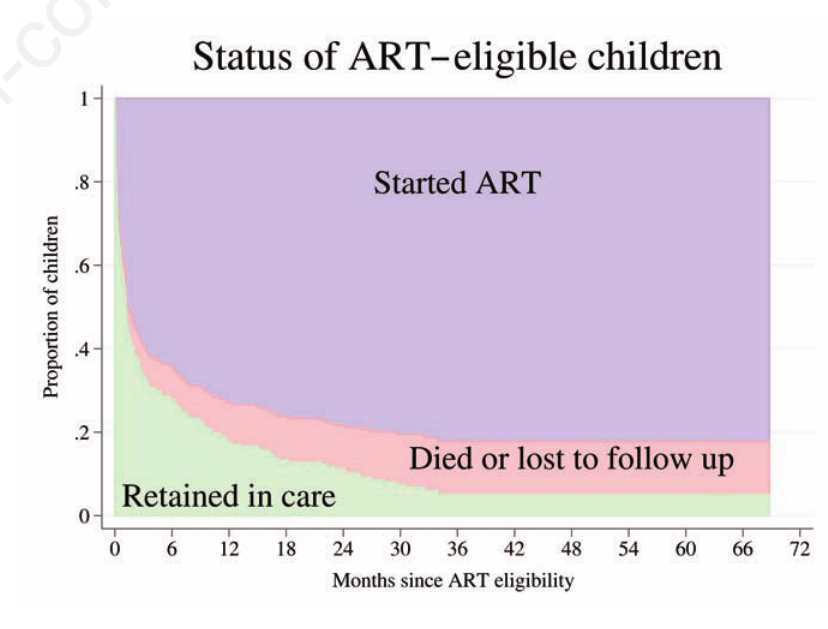
Figure 1. Stacked graph describing the cumulative incidence of antiretroviral therapy (ART) initiation and attrition in 247 ART-eligible children in Anantapur,